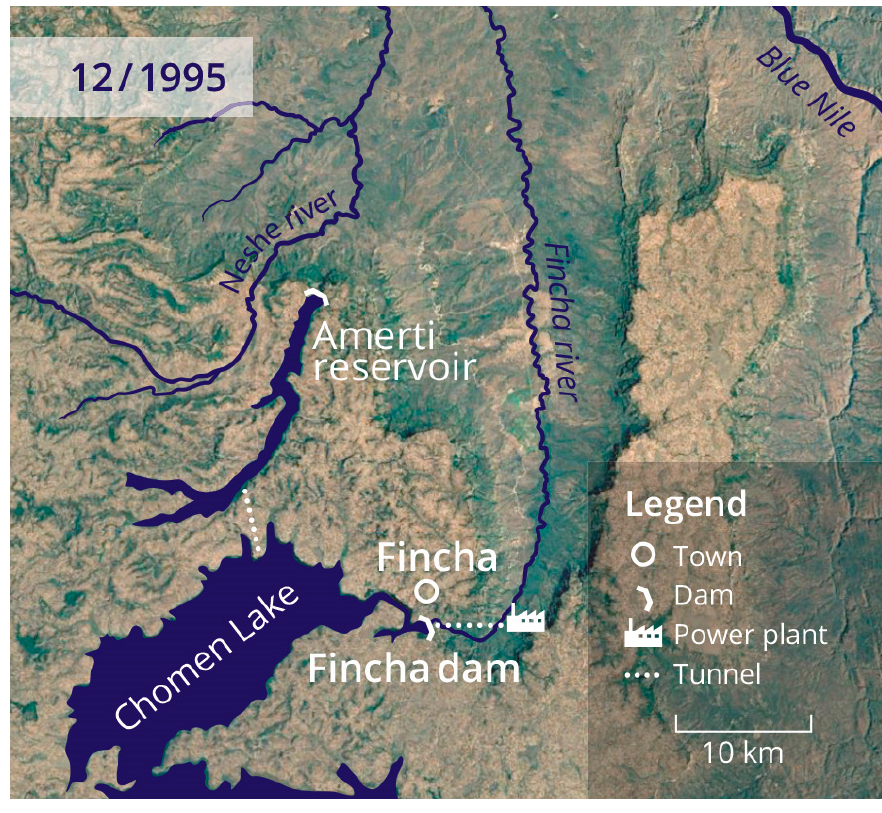
Figure 4. The study site after completion of the Amerti dam and reservoir (1987) in December 1995.